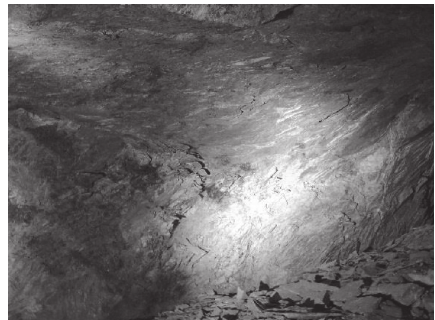
Figure 5: Slight rock burst in Ashele Copper Mine.